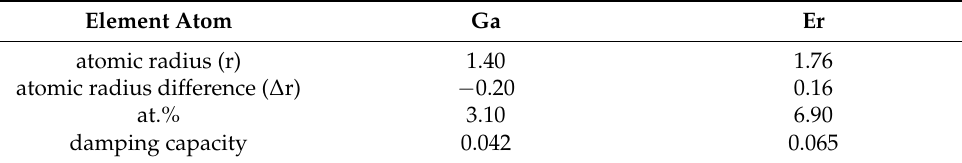
Table 3. Characteristic atomic differences between two alloying element atoms.